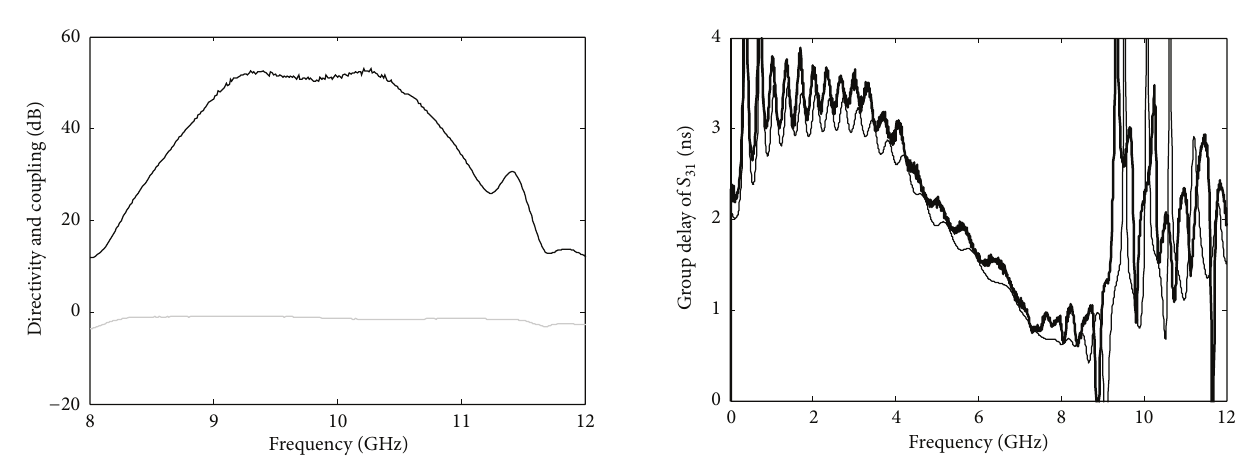
Figure 4: Measured directivity (black line) and coupling (grey line) of the designed EBG microstrip directional coupler in Figure 3.